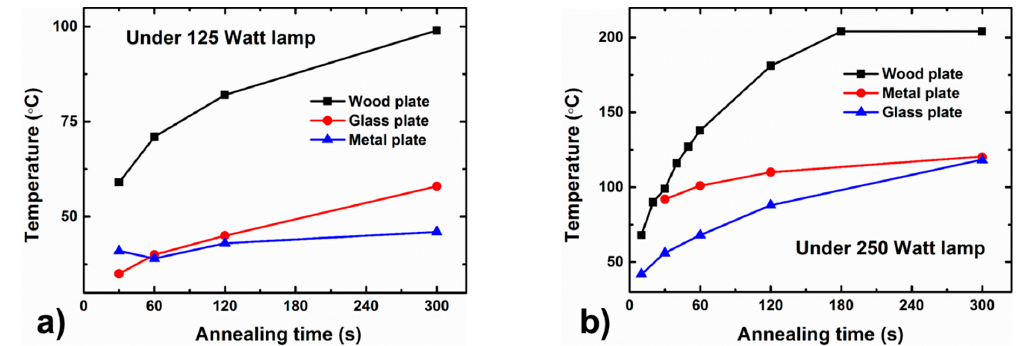
Figure 3. Sample temperature versus lamp annealing time under ( a ) 125 W lamp and ( b ) 250 W lamp when placed on wood, iron metal and glass sample supporting plates.